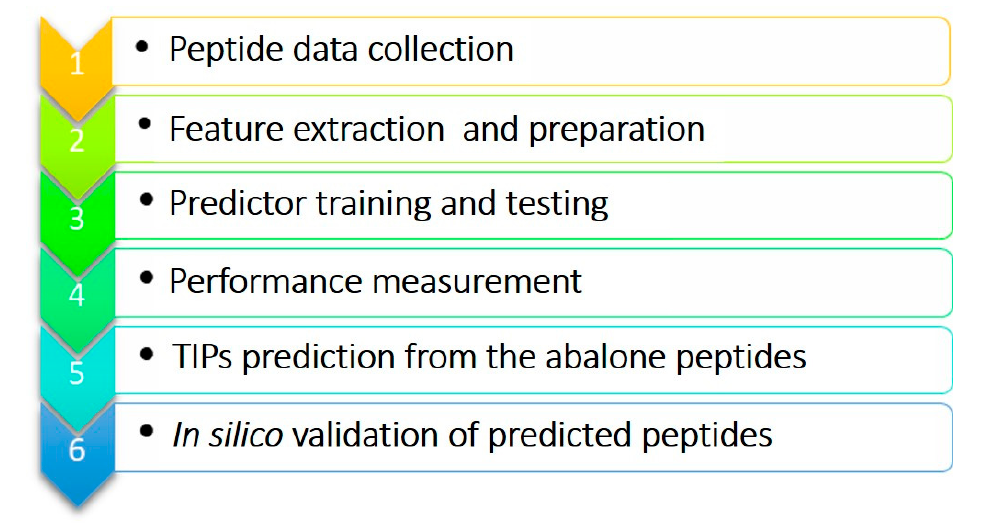
Figure 4. Workflow for bioinformatics prediction and in silico validation of the TIPs from abalone peptides.